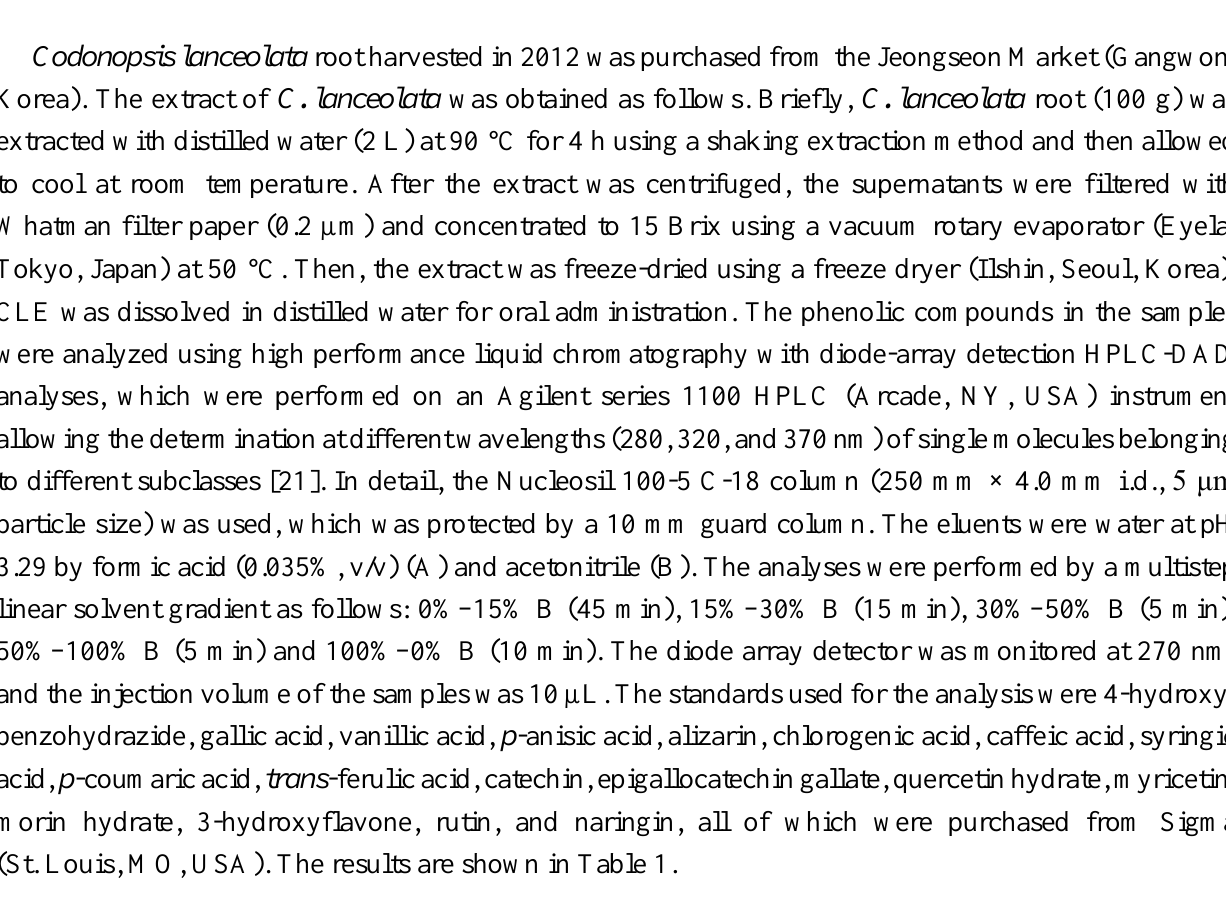
Table 1. The major phytoconstituents composing the aqueous extracts of C. lanceolata